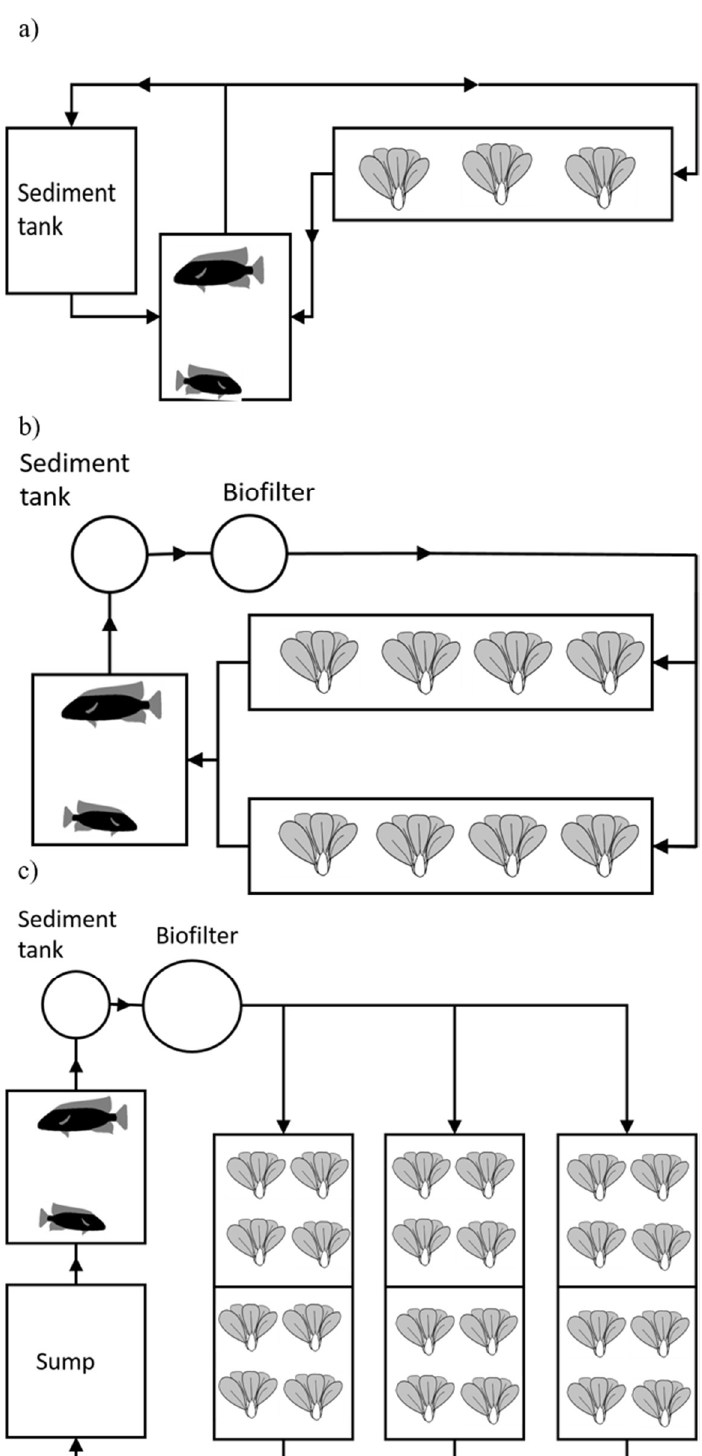
Figure 2. Schematic representation of Systems 1–3: ( a ) System 1, an F&D system with the mechanical filter and biofilter included in the pumice bed, ( b , c ) Systems 2 and 3 respectively, both DWC. System 3 had a larger volume for biofiltration and a sump for improved water quality and regulation of the water flow. Tilapia and pak-choi were cultured in this system.